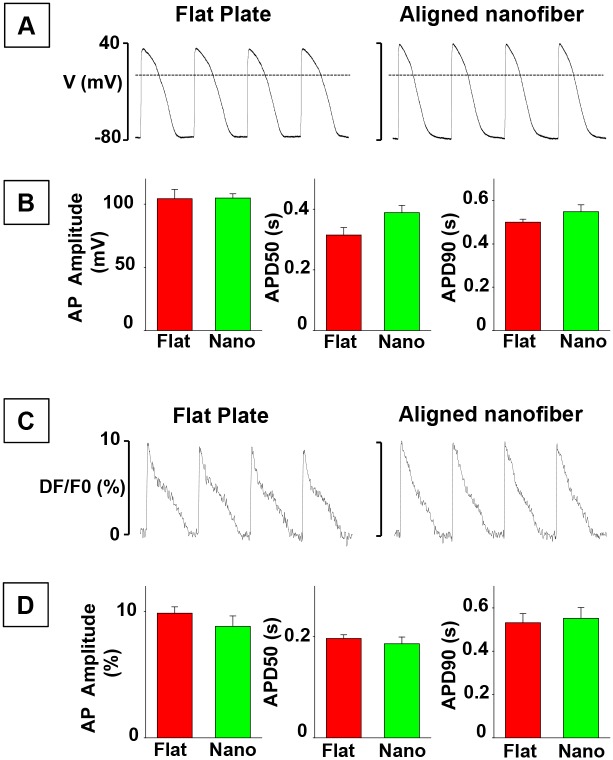
Confocal Imaging of mitochondria.Mito-tracker red staining shows alignment of Human iPSC-Cardiomyocytes seeded on A) Flat surface vs B) Aligned-nanofiber coated coverslips (32x & 200x). C) TEM imaging showing comparison of mitochondrial morphology and arrangement of hiPSC-CMs seeded on flat plate versus aligned nanofiber groups.